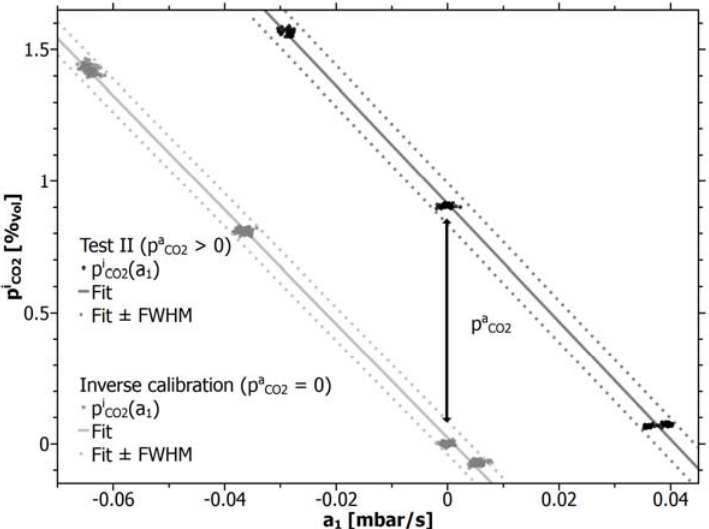
(cid:3028) (dark line). The vertical distance (cid:3004)(cid:3016) (cid:3118) (cid:3028) . (cid:3004)(cid:3016) (cid:3118)